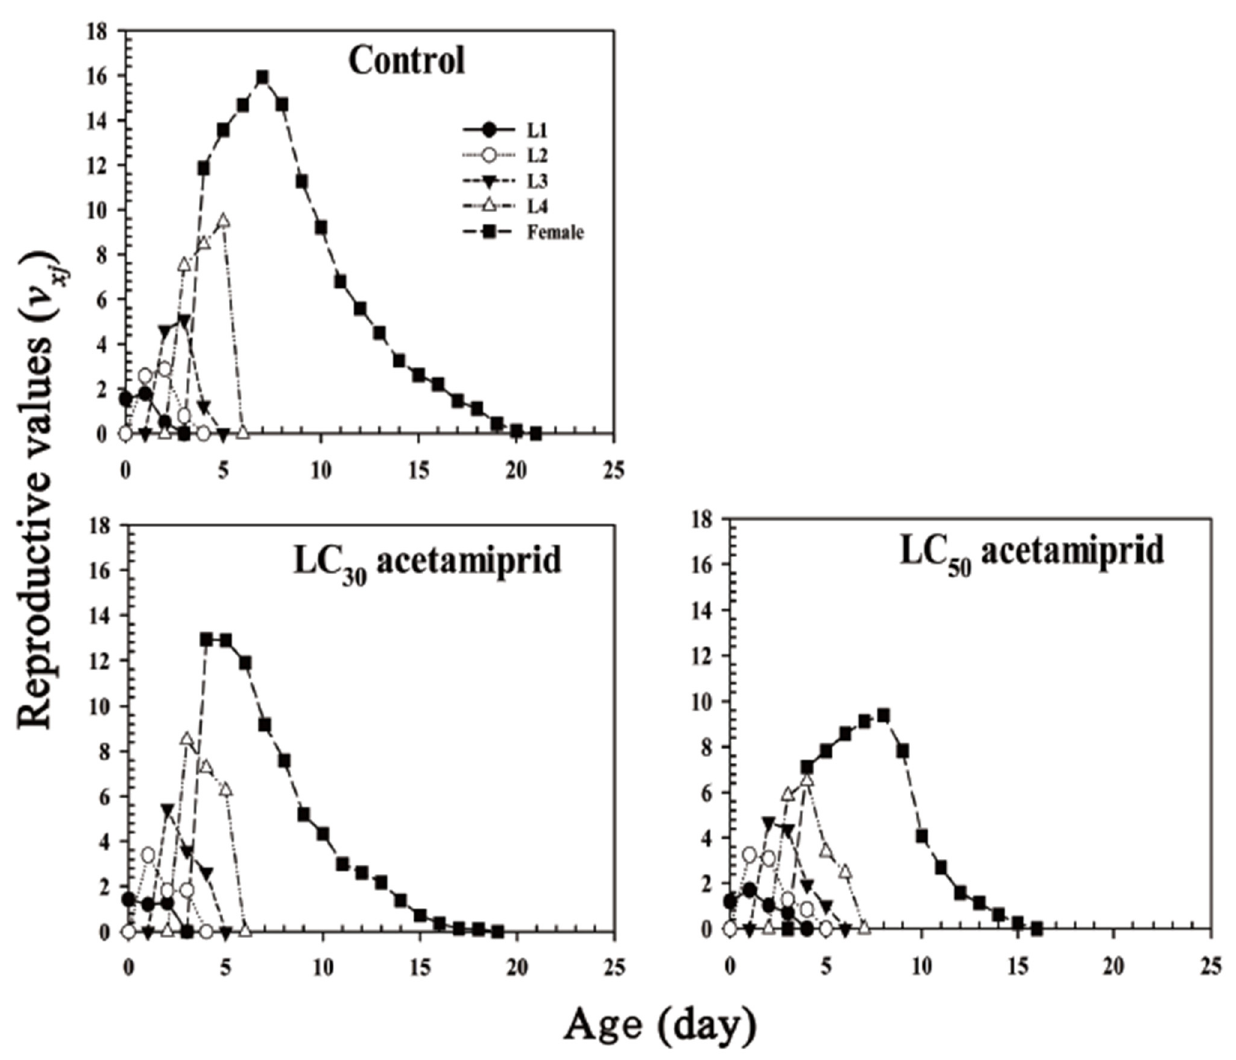
Figure 3. Age-stage specific reproductive values ( v xj ) of Aphis